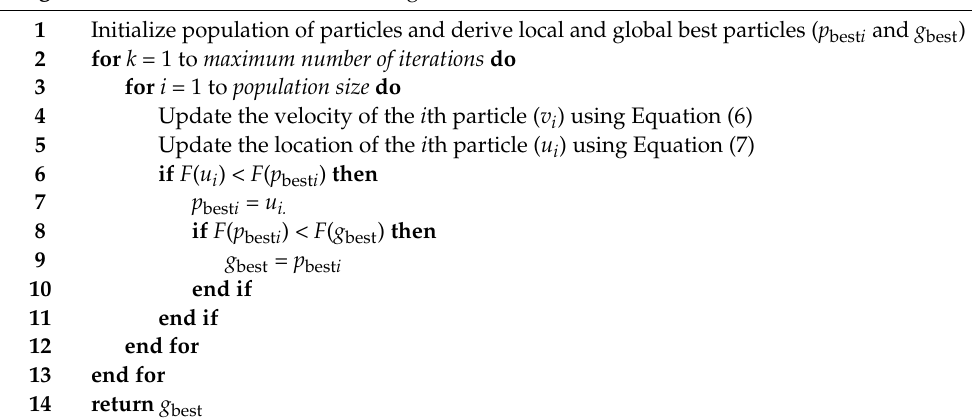
Algorithm 2: Pseudo-code of LSSVM